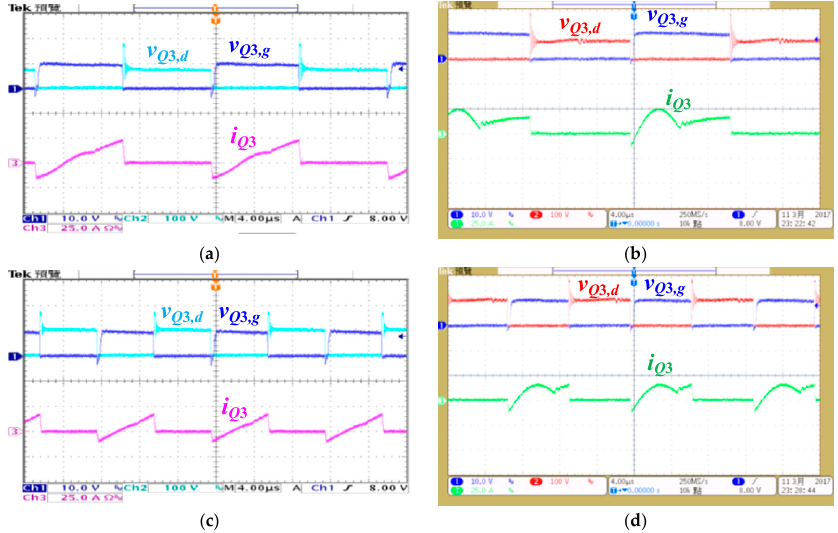
Figure 13. Test results of the power device Q 3 under backward power transfer ( a ) V L = 38 V and 20% load ( b ) V L = 380 V and 100% load ( c ) V L = 52 V and 20% load ( d ) V L = 52 V and 100% load [ v Q 3 ,g : 10 V/div; v Q 3 ,d : 100 V; i Q 3 : 25 A/div; time: 4 µs/div].